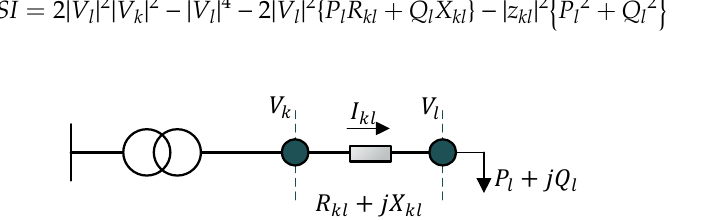
Figure 2. Single line diagram representation of balanced radial distribution system